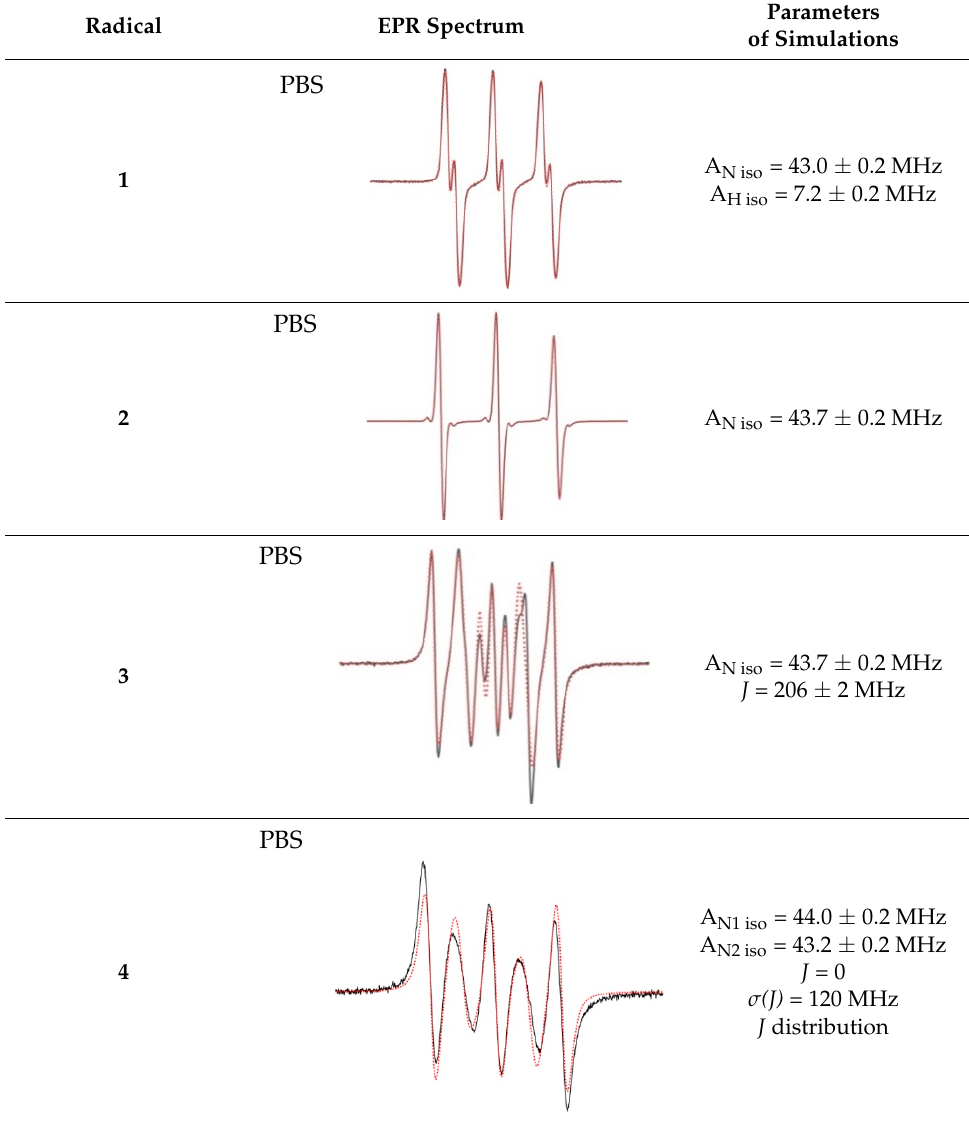
Table 1. R.t. X-band EPR spectra of ~0.1 mM radicals 1 – 4 .